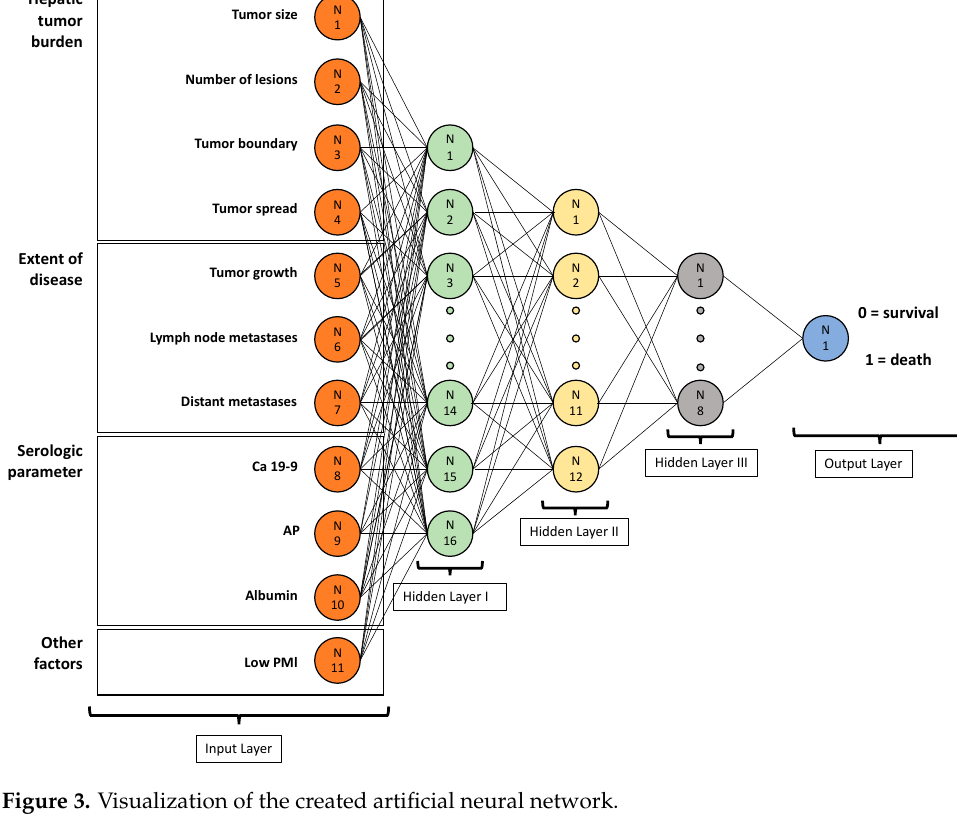
Figure 3. Visualization of the created artificial neural network.